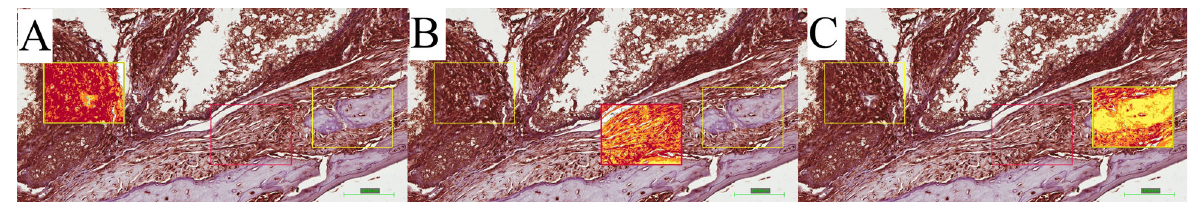
Fig. 10 Photomicrograph showing colour deconvolution of selected areas in the cranial bone defect sections immune-stained with osteo- pontin. A Area at the centre of the defect with intensity 61.48 ± 13.